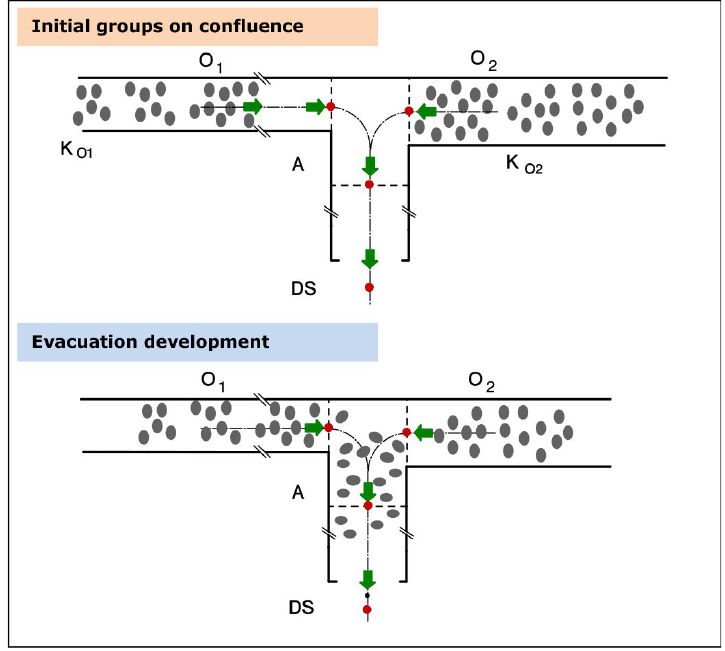
Figure 14. Existence of groups in a confluence